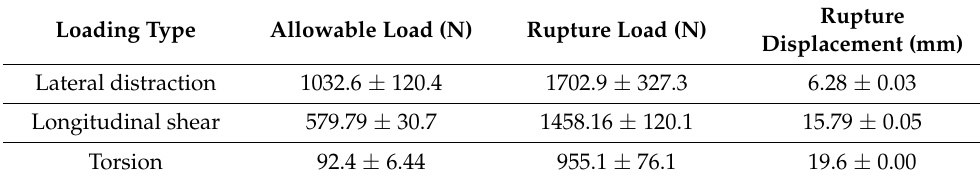
Table 6. Allowable load and rupture load values of different loading types and their resultant rupture displacement values [103].